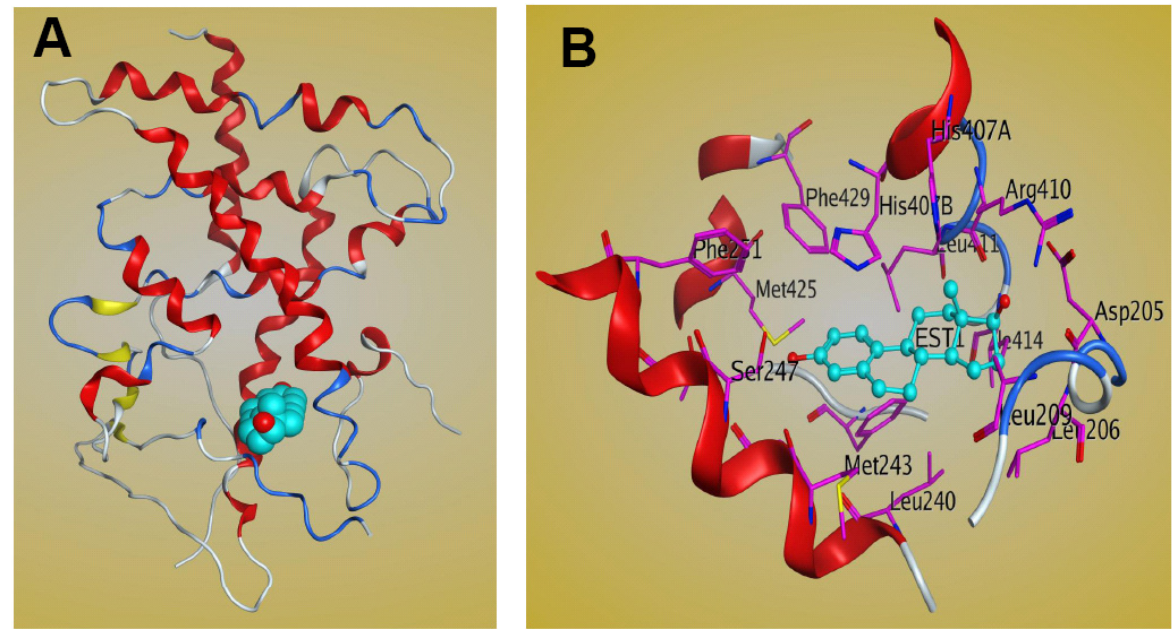
Figure 4. Structure of the PXR LBD–17 β estradiol complex. ( A ) Ribbon representation of the PXR LBD bound to the 17 β estradiol ligand (cyan). ( B ) Interactions between the PXR LBD and 17 β estradiol within the ligand-binding pocket. The figure was generated